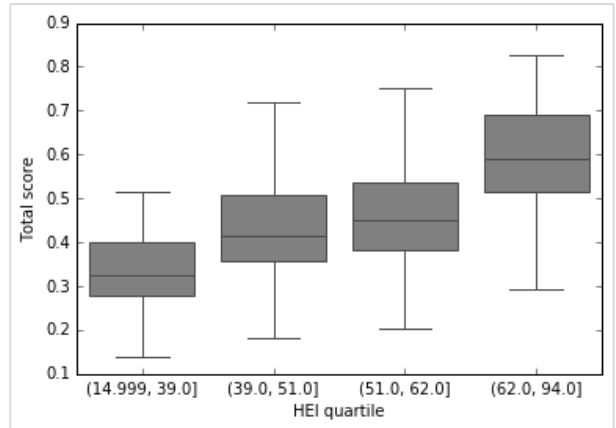
Figure 5. HEI vs. NNA score by quartile for day 1 for women aged 31 – 50 years, non-pregnant and non-lactating ( n = 155). This shows the relationship between the HEI score by quartile (x axis) and the NNA score (y axis) for a subset of NHANES data. NHANES: National Health and Nutrition Examination Survey, NNA: Nestlé Nutrition Algorithm, HEI: Healthy Eating Index.